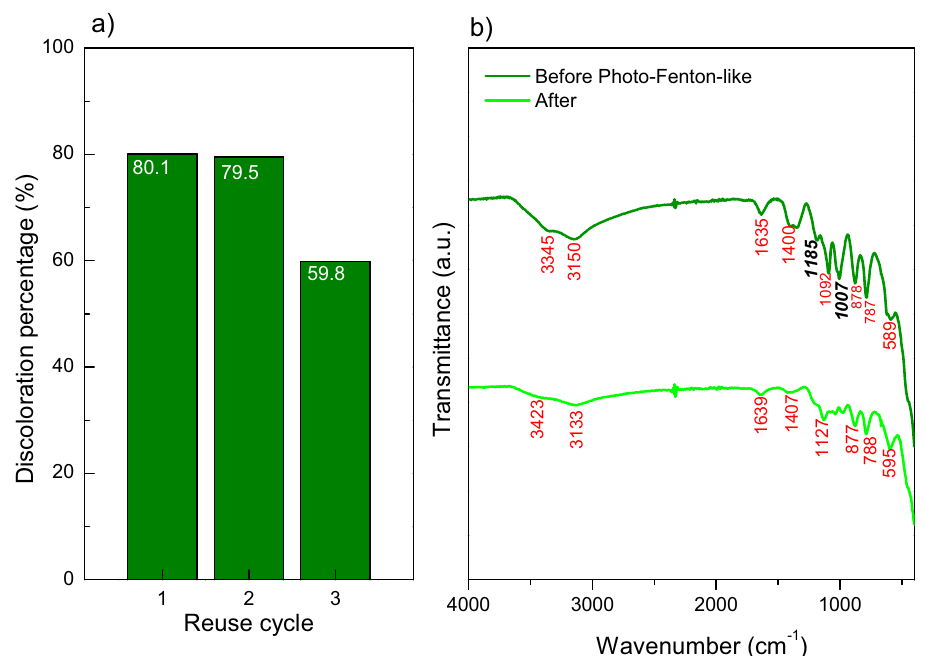
Figure 7: ( a ) MB discoloration e ffi ciency after 120 min of photo - Fenton - like reaction for 3 consecutive cycles of reuse of a - FeOOH and ( b ) FTIR spectra of the catalyst a - FeOOH before and after the photo - Fenton - like